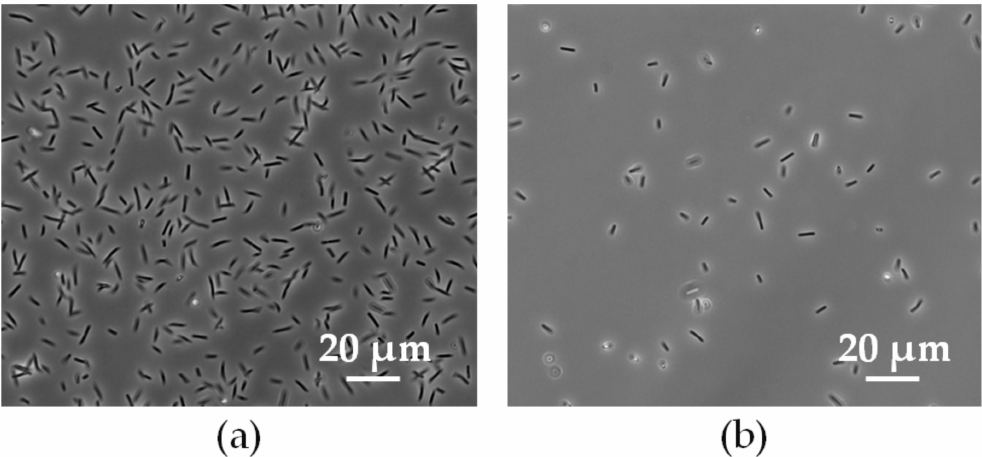
Figure 1. 215 µ m × 165 µ m large optical microscopy image of the gram-positive L. sphaericus JG-A12 cells before treatment with antibiotics with ( a ) OD2.0 (6.0 × 10 8 cells/mL) and with ( b ) OD0.5 (1.5 × 10 8 cells/mL) before plating, scale bar 20 µ m.